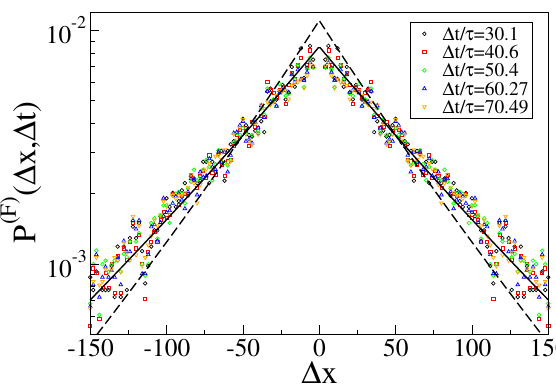
Figure 8: For the IK model, we show numerical results for the normalized probability distribu- tion P ( F ) ( ∆ x , ∆ t ) at different times, as obtained from the Van Hove distribution by removing the δ -peak in the origin. The dashed line represents the theoretical prediction for P ( F ) ( ∆ x , ∆ t ) of Eq. 34, while the full line is the rescaled distribution ( 1 /α ) P ( F ) ( α ∆ x , ∆ t ) with α = 1.3. ∆ t (cid:28) or, for Γ IK